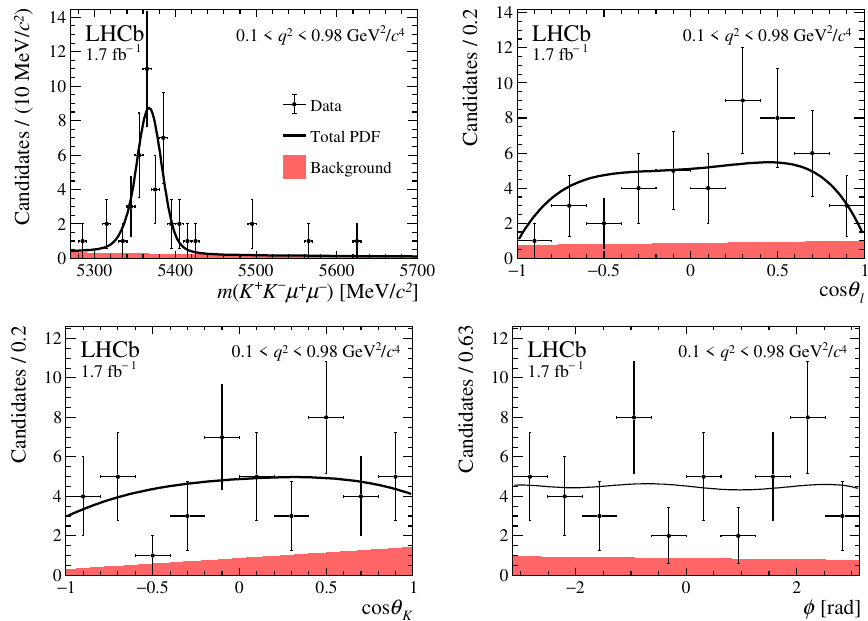
Figure 13 . Mass and angular distributions of B 0 0 . 1 < q 2 < 0 . 98 GeV 2 /c 4 for data taken in 2016. The data are overlaid with the projections of the fitted